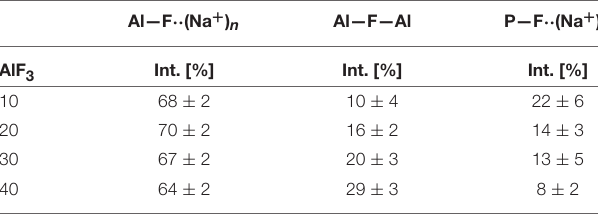
TABLE 5 | 19 F intensities of (100-x)NaPO 3 – x AlF 3